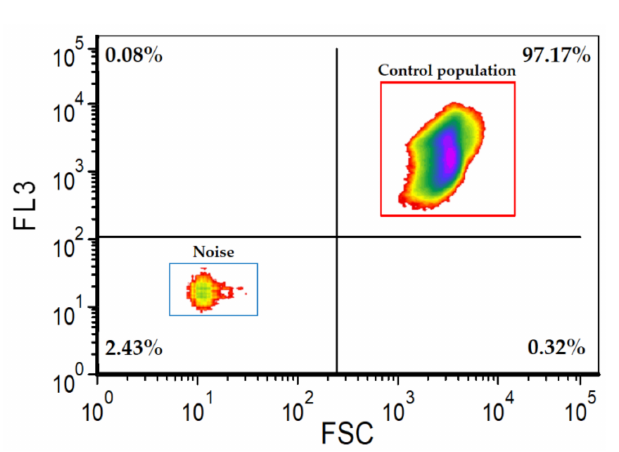
Figure 1. FSC vs. FL3 dotplot with rectangular gates for quantification of microalgae control population.